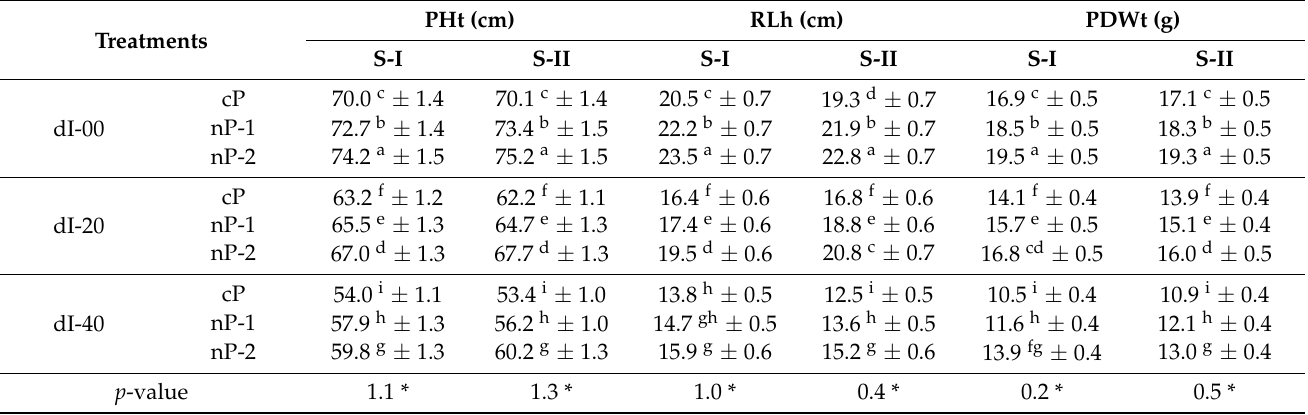
Table 3. Growth traits of fenugreek plants as affected by different irrigation water regimes and soil and foliar nourishing with phosphorus (P) during two growing seasons.